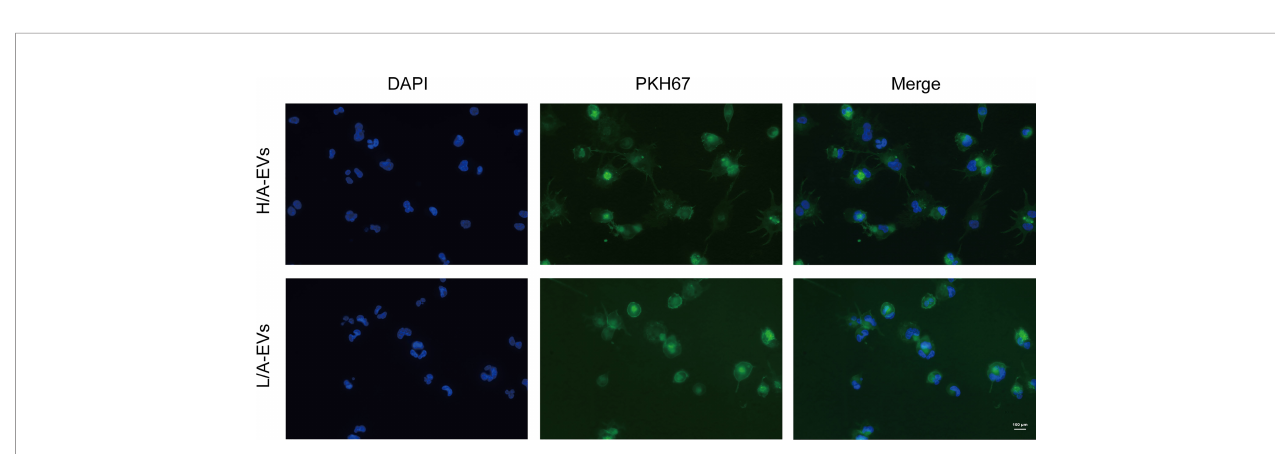
FIGURE 6 | Uptake of PDE-EVs by macrophages. PDE-EVs from the H/A group or the L/A group labeled with PKH67 (green) were separately added to the culture of macrophages for 24 h. The labeled EVs were distributed around the DAPI-stained nuclei (blue). This colocalization was determined using fl uorescence microscopy. The results shown are from one representative of three independent experiments. DAPI, 4 ′